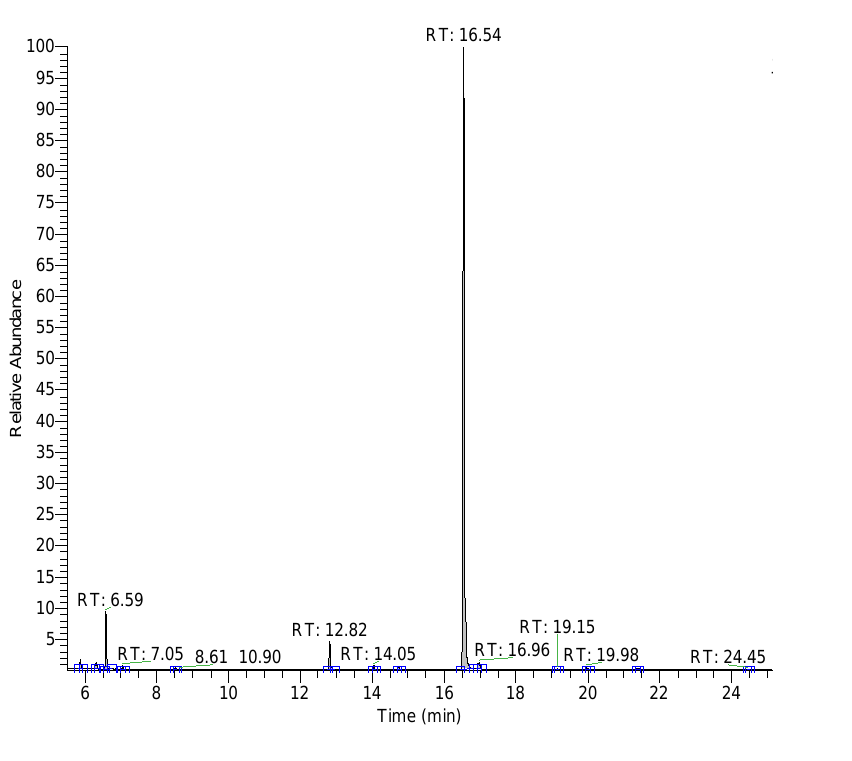
Figure 2. Gas chromatogram of cinnamaldehyde-type C. osmophloeum leaf oil. Table 1. Composition of Cinnamomum osmophloeum leaf oil.